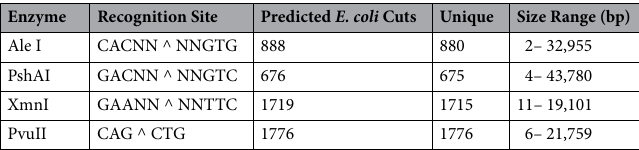
Table 1. Enzymes used for generating